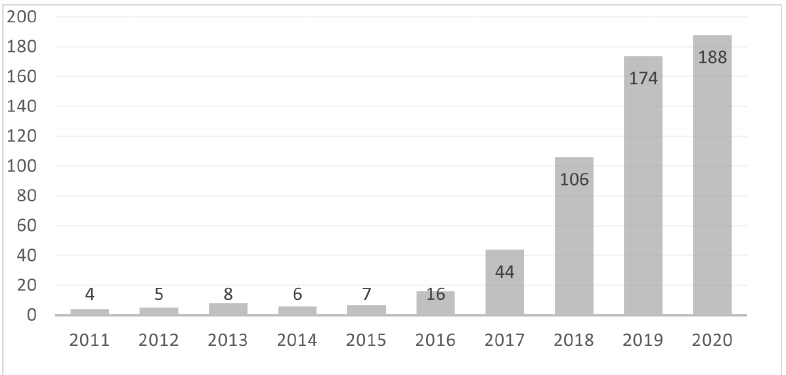
Figure 8. Number of publications on deployment/placement of UAV-BSs From the Web of Science Core Collection.